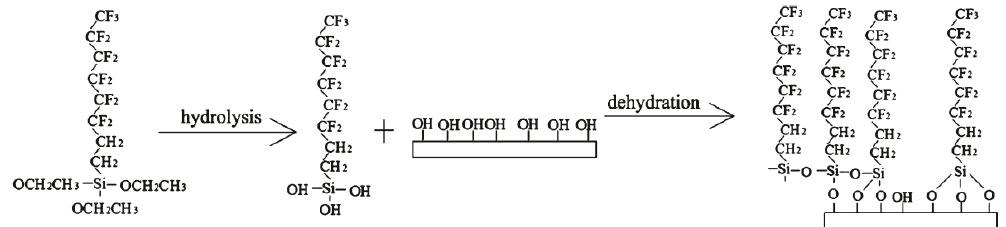
Sensors 2016 , 16 , 1060